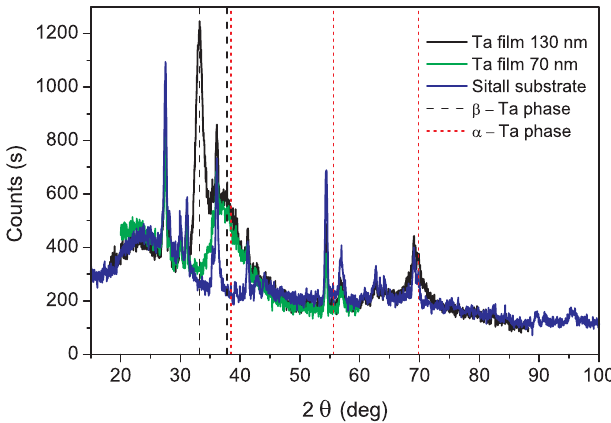
Figure 1. X-ray diffraction (XRD) analysis of the grown Ta/Sitall films. XRD spectrum of the blank Sitall substrate (blue line) and of the Ta films with thickness of 130 and 70 nm (black and green lines, respectively). The reflection positions corresponding to α - and β -Ta phase are shown by the dashed